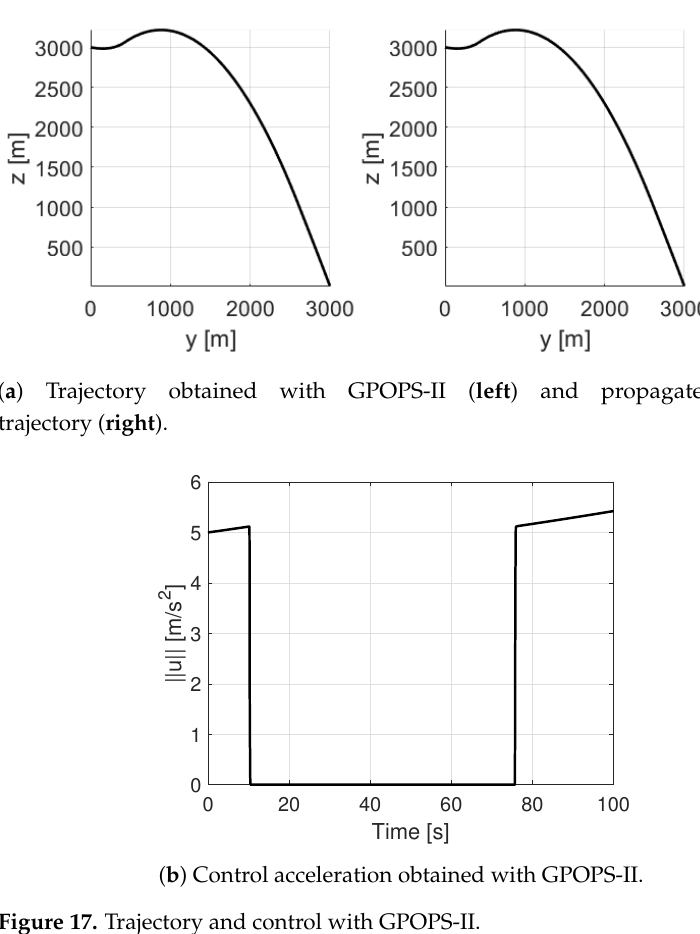
Figure 17. Trajectory and control with